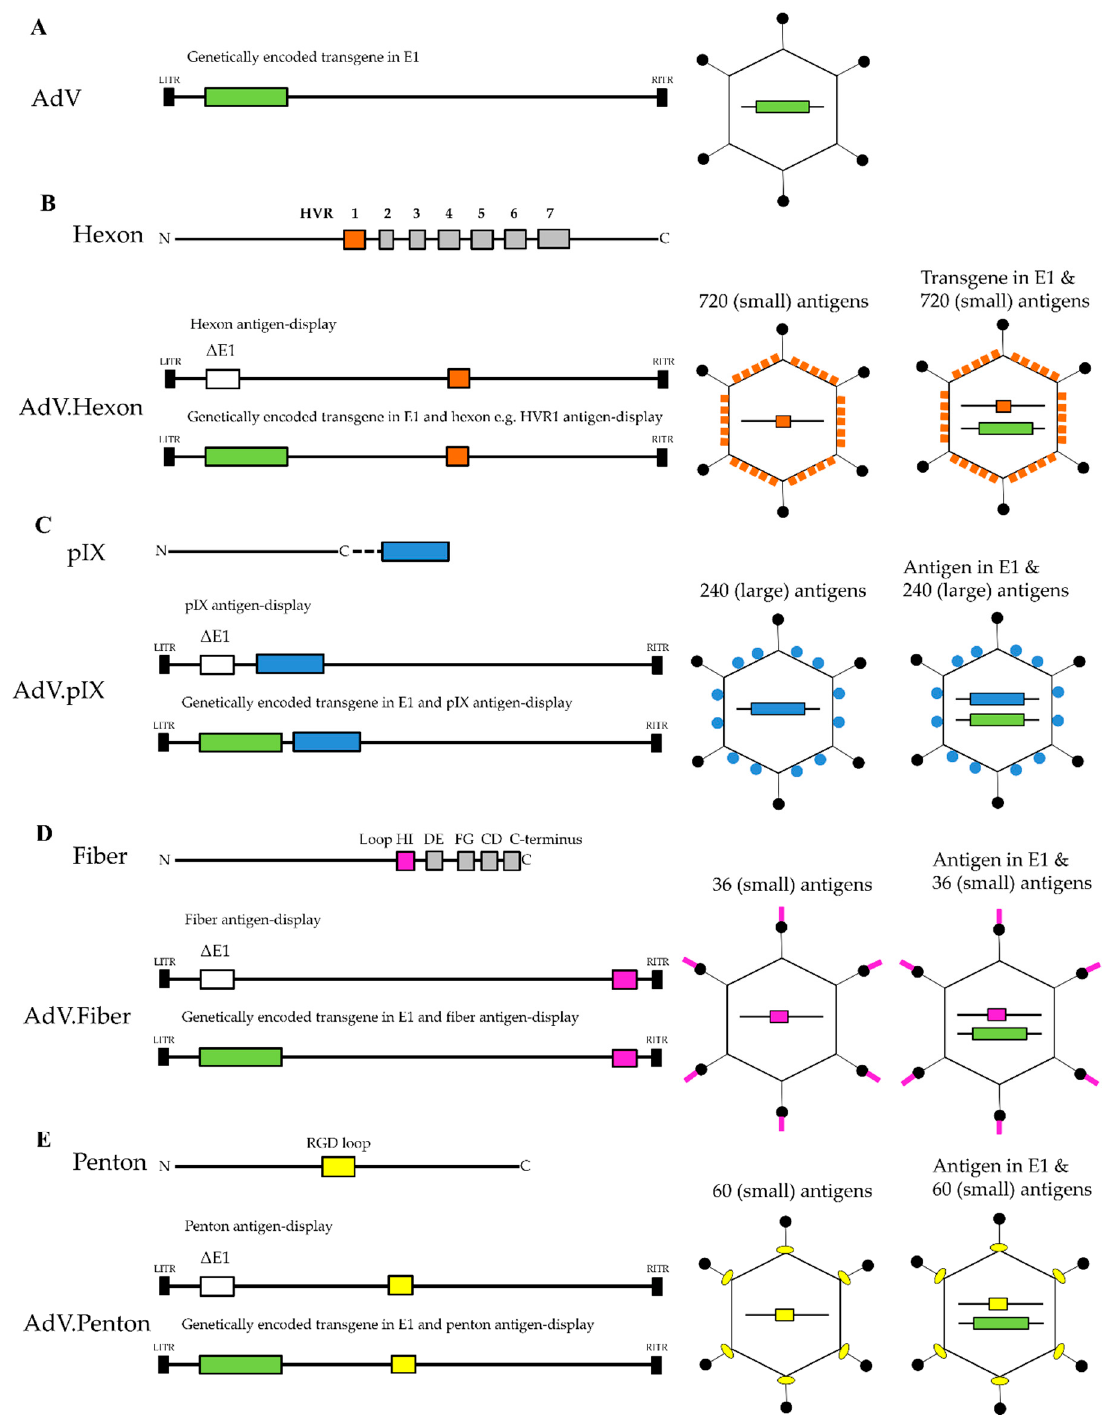
Figure 2. Schematic overview of capsid-display AdV vaccine vectors. ( A ) Replication-incompetent ( Δ E1) AdV vectors encoding a transgene (green) in E1 (AdV.E1). ( B ) Hexon protein contains seven hyper variable regions (HVR1–7). The size in amino acids (aa) can vary per AdV type e.g., HAdV5 HVR1 44 aa (137–181), HVR2 6 aa (187–193), HVR3 7 aa (211–218), HVR4 13 aa (247–260), HVR5 15 aa (267–282), HVR6 11 aa (304–315) and HVR7 28 aa (421–449). Single epitope can be inserted in or substitute the native HVR sequence resulting in 720 copies per capsid. AdV. Hexon display vectors are generated (e.g., HVR1 orange) with or without a genetically encoded transgene in the E1 region (green). ( C ) pIX can display 240 copies of linear peptides or globular proteins (blue) by fusion of the